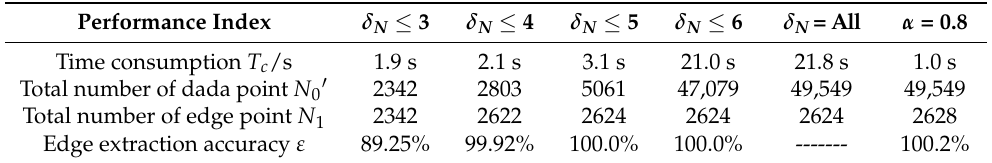
Table 2. The performance comparison among different boundary extraction method conducted on the point cloud data of involute cylinder gear.